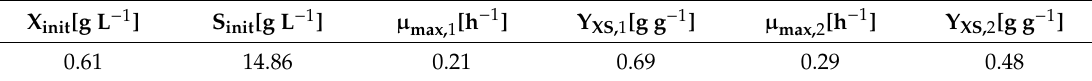
Table A21. Estimated initial concentrations for biomass X init and glucose S init and the estimated model parameters for the maximum specific growth rate biomass µ max and yield coe ffi cient biomass / substrate Y XS (for batch phase index 1 and for fed-batch phase index 2).